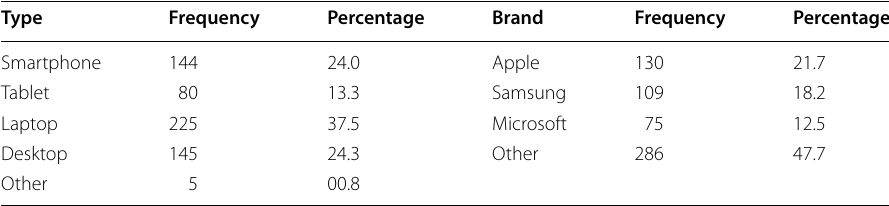
Table 2 Smart device usage of the